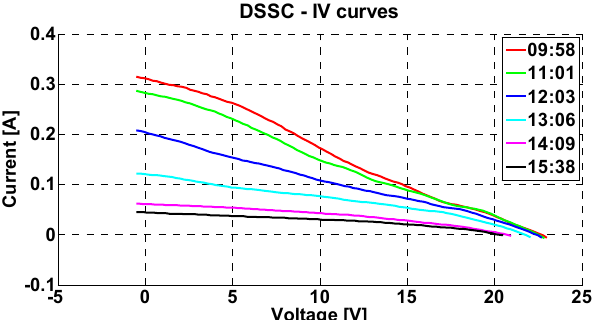
Figure 16. DSSC cell current-voltage curves for different irradiance values.